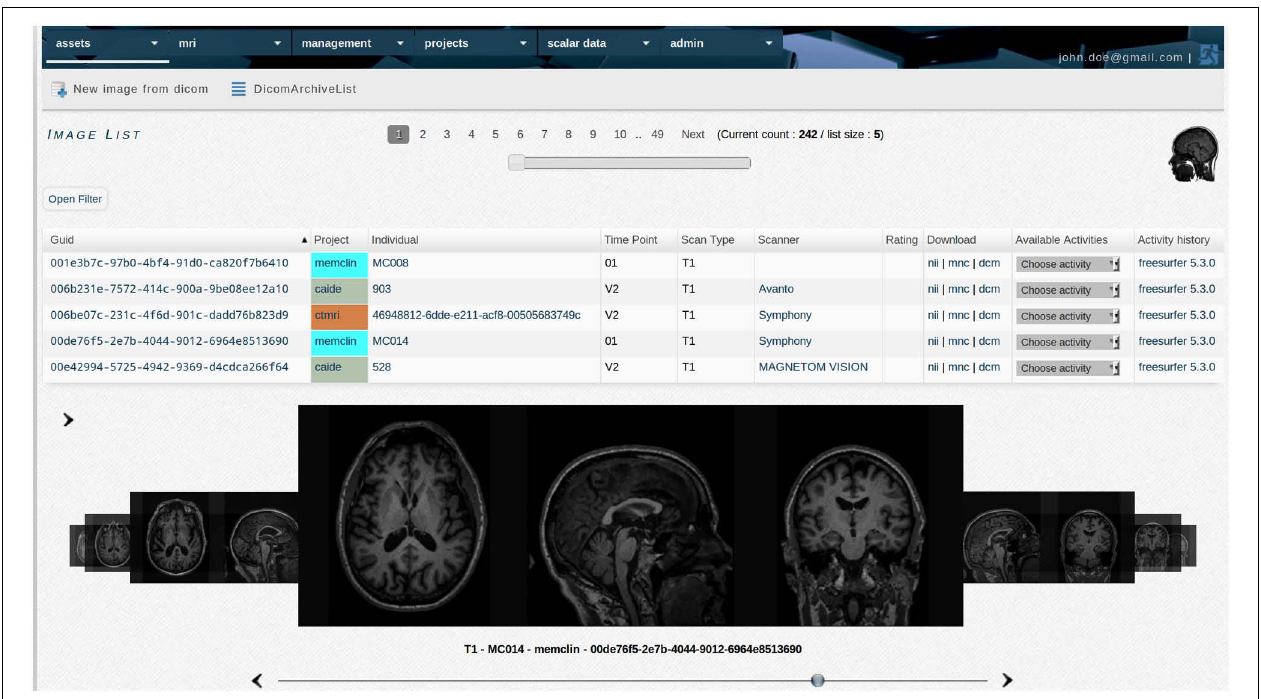
FIGURE 5 |TheHiveDB image library provides access to the quality control interface and allows the user to request processing of images. List items are links to individuals, actual image data in various formats for direct download, scanner information, and activity history,